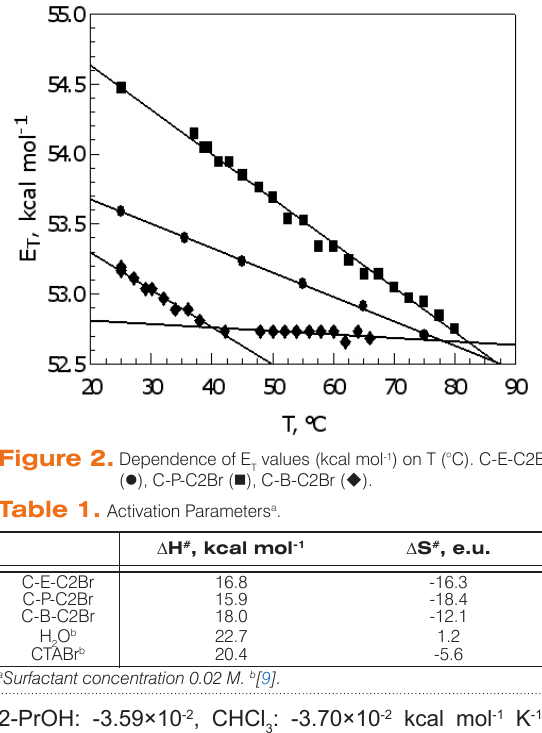
Figure 2. Dependence of E values (kcal mol -1 ) on T (°C). C-E-C2Br T (  ), C-P-C2Br (  ), C-B-C2Br (  ). Table 1. Activation Parameters a . ∆ H # , kcal mol -1 ∆ S # ,